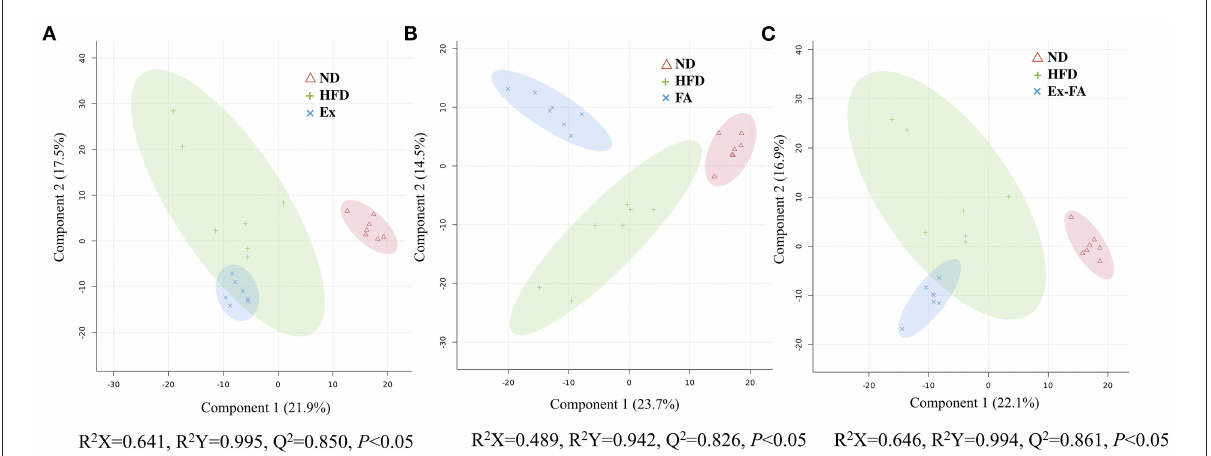
FIGURE6 PLS-DA score plots. (A) The PLS-DA score plot of ND, HFD, and Ex groups; (B) The PLS-DA score plot of ND, HFD, and FA groups; (C) The PLS-DA score plot of ND, HFD, and Ex-FA groups. ND, normal diet group (control); HFD, high-fat diet group (model); Ex, high-fat diet with exercise; FA, high-fat diet with ferulic acid; Ex-FA, high-fat diet with exercise and ferulic acid.